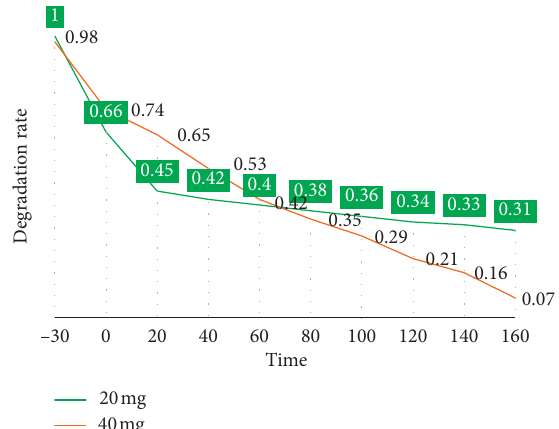
Figure 4: The relationship between compression factor and compaction.